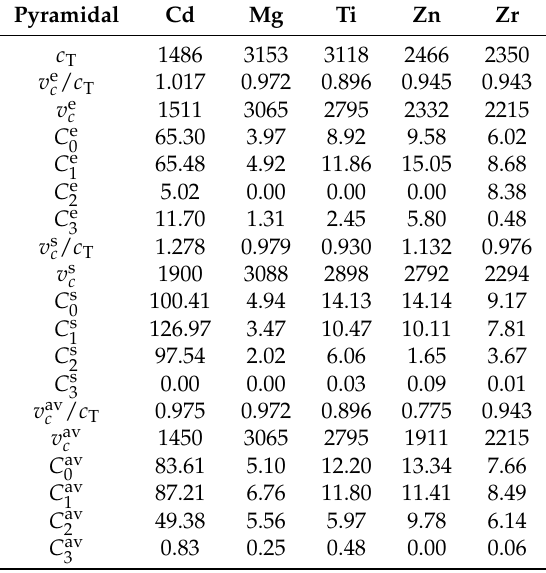
Table 6. List of critical velocities v c (m/s), and fitting function coefficients C i ( µ Pas) for pyramidal slip. The critical velocities are given in units of m/s as well as in ratio to c T . The fits are only valid up to 0.99 c T and do not capture the asymptotic behavior for those metals/dislocations whose critical velocity is larger than this value. Superscripts “e”, “s”, and “av” refer to “edge”, “screw”, and “average”, respectively. Furthermore, v av c coincides with the smallest critical velocity for all dislocation characters ϑ within the pyramidal slip system. Pyramidal Cd Mg